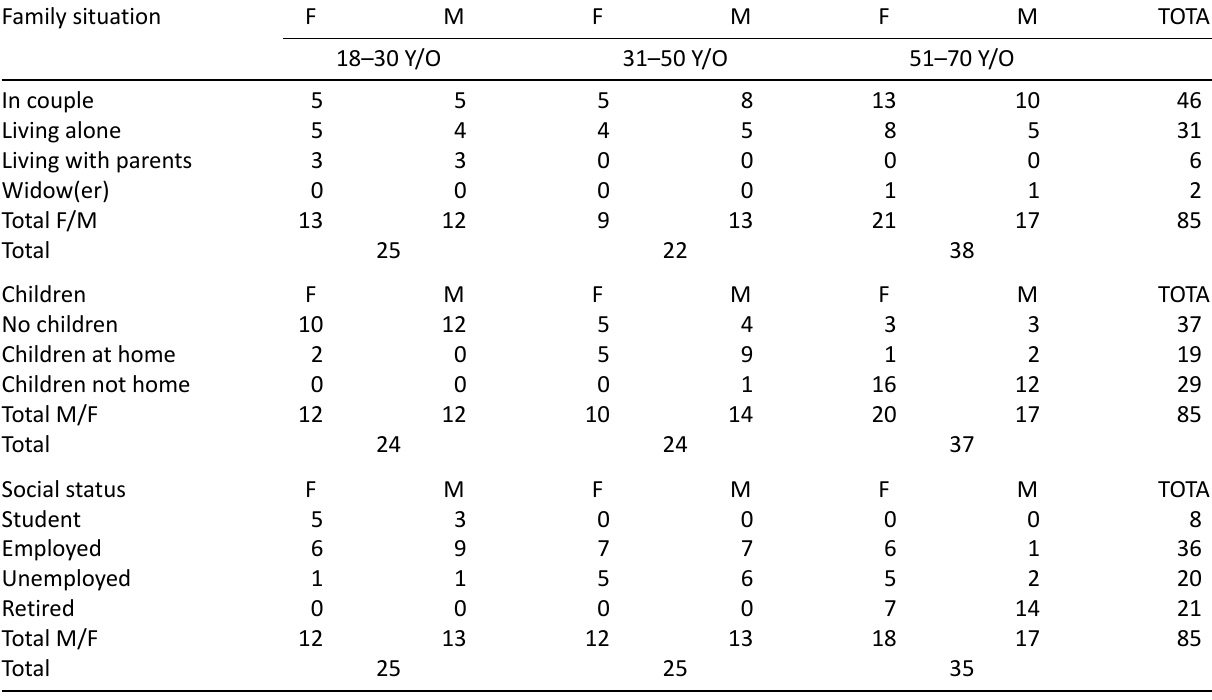
Table 2. Overview of the respondents: Additional criteria. Family